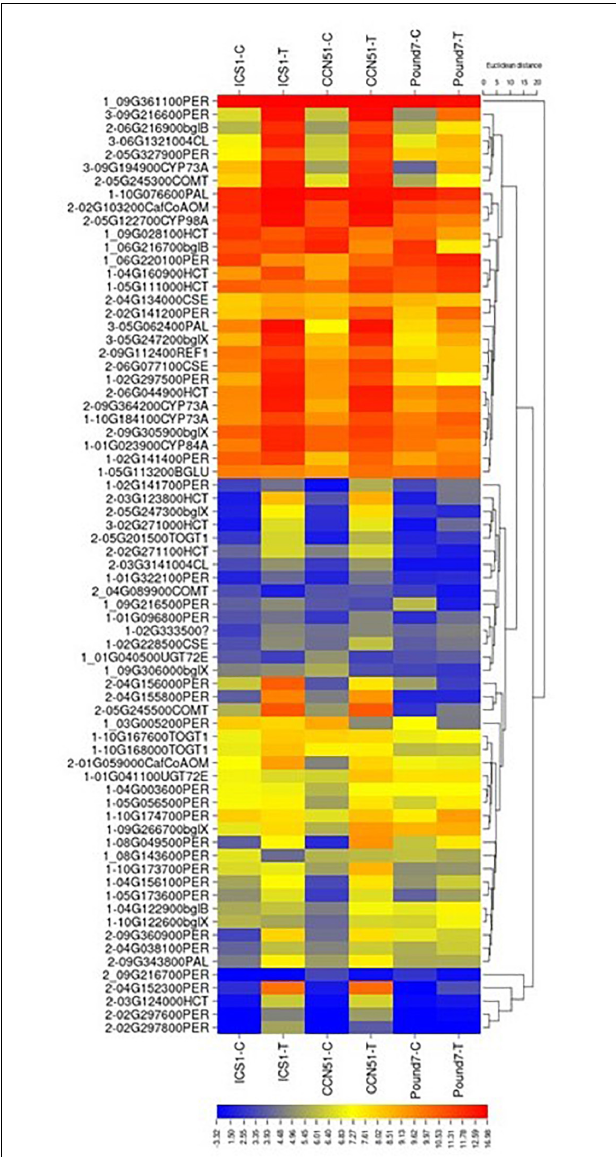
FIGURE 7 | A heat map displaying relative expression levels of cacao genes involved in the Phenylpropanoid Biosynthesis (KEGG map00940) pathway in young red leaves of ICS1, CCN51, and Pound7 24 h after inoculation with 20- µ l drops of zoospores (0.6 × 10 5 zoospores/ml). Initial numbers indicate the number of genotypes with significant differential expression between treated and control samples. The following – and _ indicate upregulated and downregulated genes, respectively. The following numbers represent gene identifications in the cacao transcriptome ( Supplementary Data Sheet 1 ). Terminal letters indicate the gene function/pathway step.